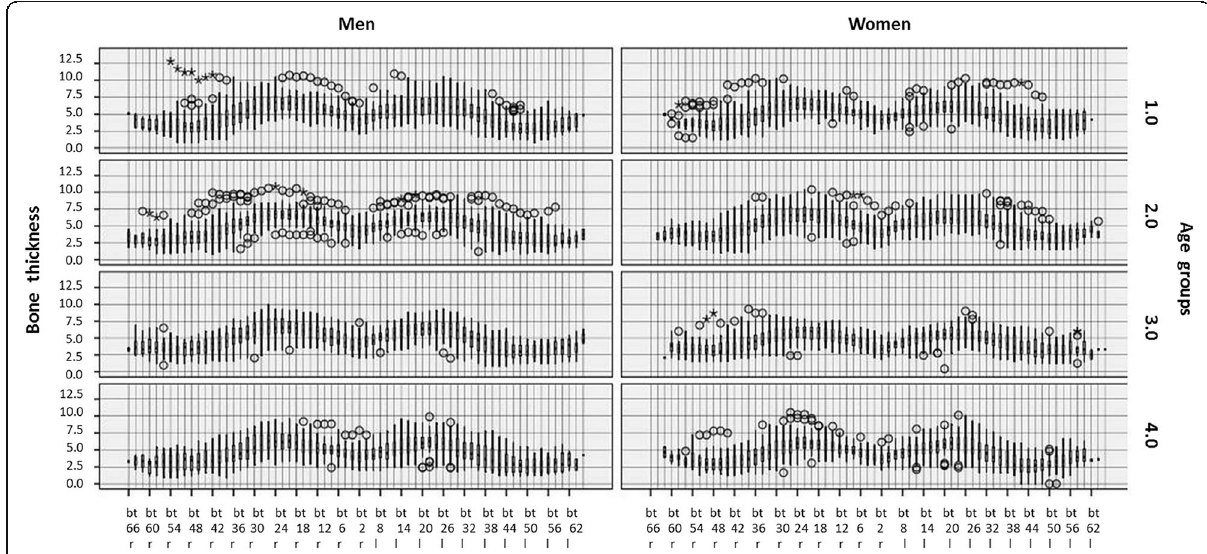
Fig. 4 Left (l) and right (r) mandibular bone thickness (bt) in the four age groups (group 1, 0 – 20 years old; group 2, 21 – 40 years old; group 3, 41 – 60 years old; group 4, 61 and older) in men (0) and women